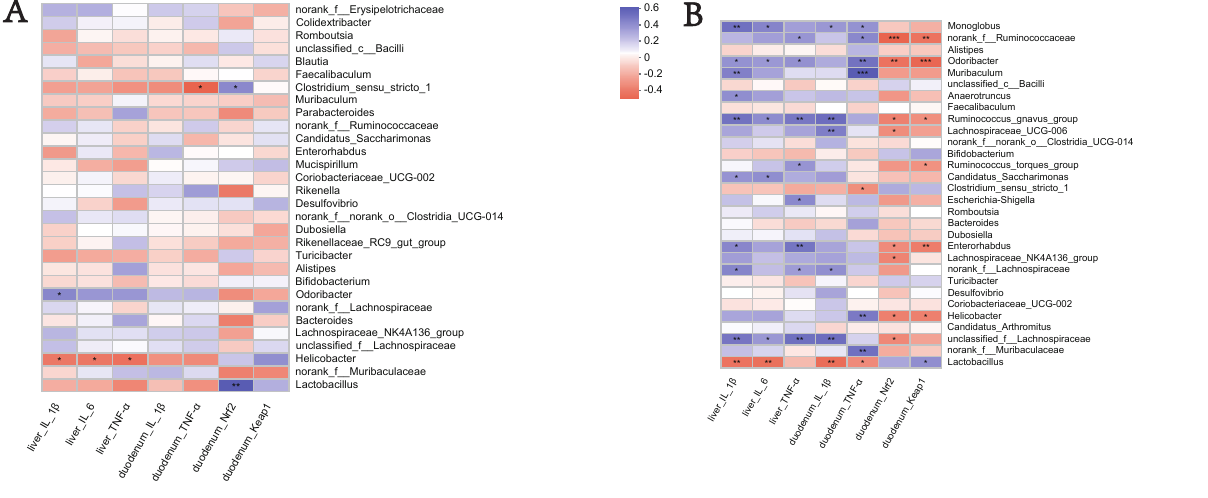
Figure 10. Key genera involved in mediating pro-inflammatory and antioxidant genes in the liver and duodenum: ( A ) fecal; and ( B ) intestinal digesta. Significant correlations are indicated in red for positive correlations and blue for negative correlations, while the independent color bars on the right depict correlation coefficients between the microbiota and genes. The correlation was considered significant when the absolute value of Spearman’s rank correlation coefficient was >0.6, and statistically significant when p < 0.05. The significance was as follows: * p < 0.05, ** p < 0.01, *** p < 0.001. IL-1 β , interleukin 1 β ; IL-6, interleukin 6; TNF- α , tumor necrosis factor alpha; Nrf2, nuclear factor E2-related factor 2; Keap1, Kelch-like ECH-associated protein